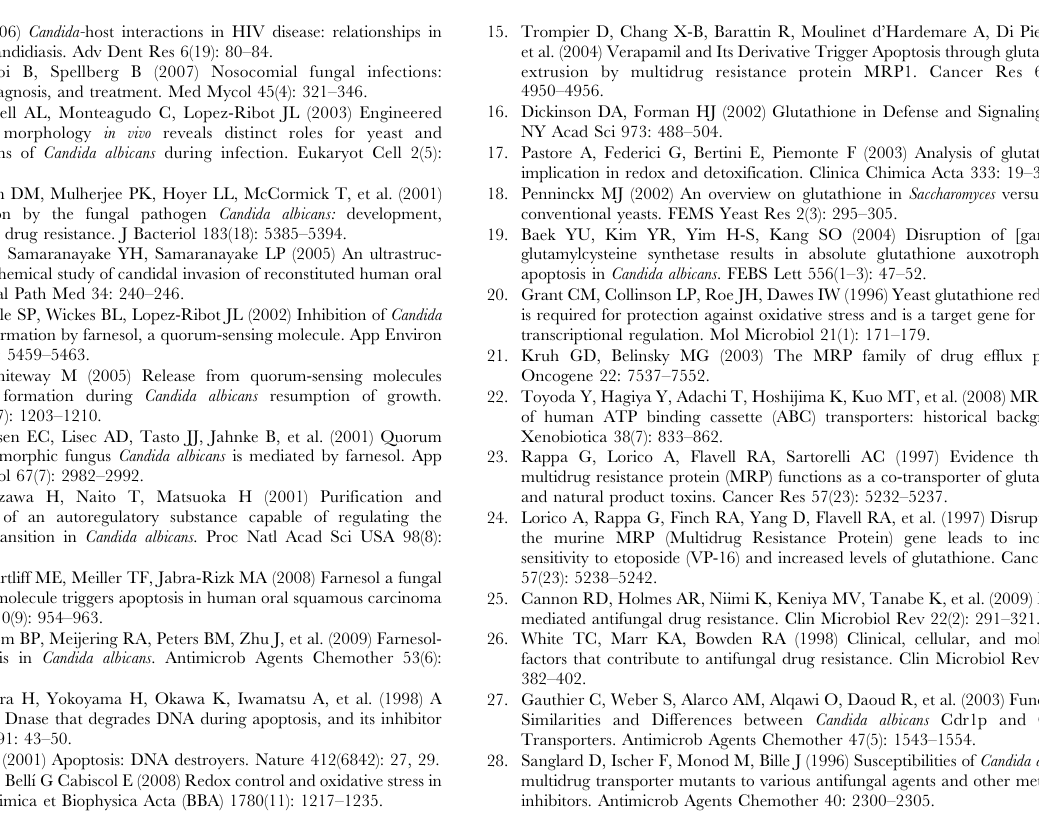
Figure S1 Complementation of CDR1 inactivation analyzed by ( A ) Western analysis with a Cdr1p antibody. Wild type Cdr1p signal is restored in the revertant DSY4481 and ( B ) drug resistance phenotype. Wild type fluphenazine susceptibility is restored in the revertants (two independent transformants were spotted).